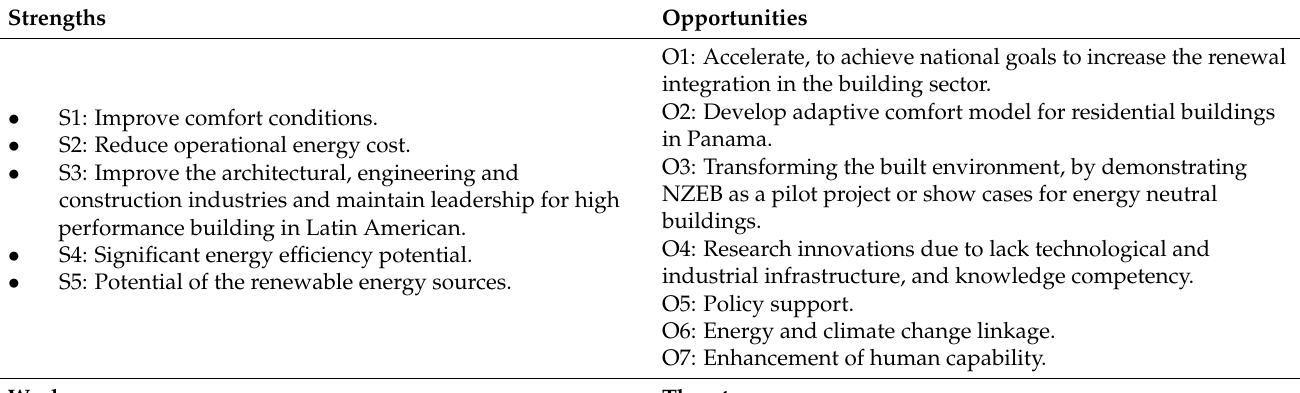
Table 7. SWOT Analysis for apply nZEB in Panama, based on and adapted from experiences reported in [79–83]. Strengths